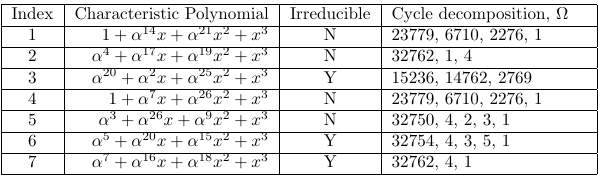
Table 1. Complete cycle decompositions of the WG- NLFSR for n = 3 over F 2 5